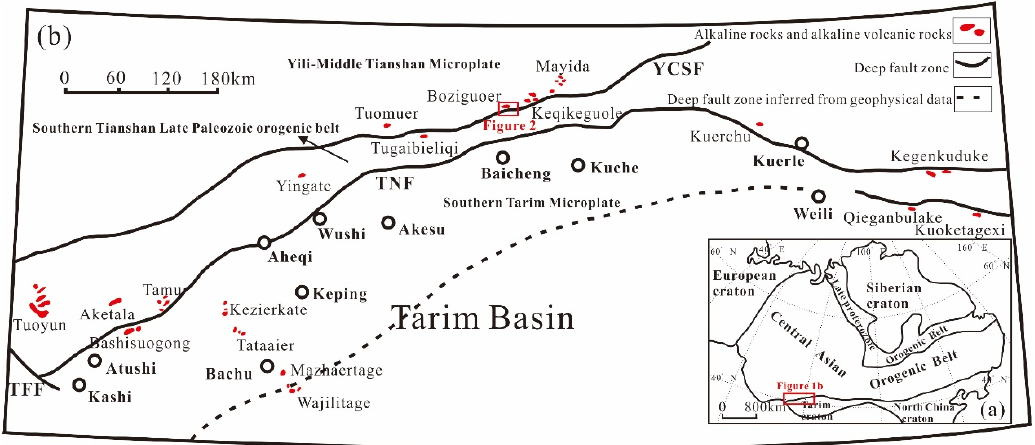
Figure 1. ( a ) Tectonic units and location of Southern Tianshan region in Xinjiang, NW China (modified from [58]); ( b ) distribution of the Boziguoer deposit in the Southern Tianshan region and coeval alkaline felsic rocks in the Tarim north rim (modified from [60,61]).